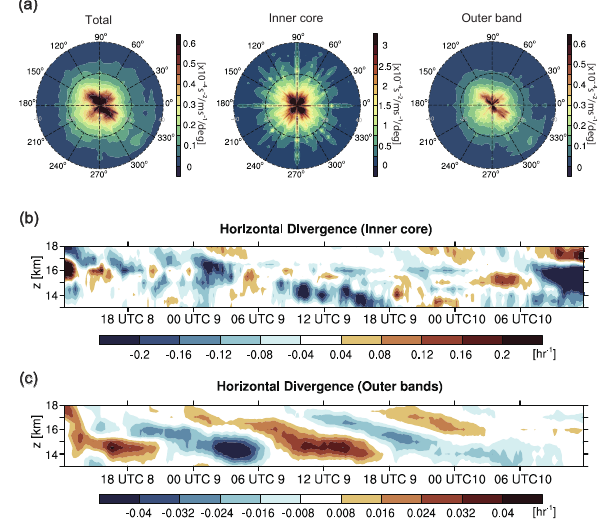
Fig. 5. (a) PSD of the HDTGW at 16kma.g.l. with respect to the horizontal phase speed (radius) and propagation direction (az- imuthal angle) in the total (left), inner core (middle), and outer rain- bands (right) regions of D3. The inner core is defined by a 150km radius from the typhoon center, and the outer rainband region is de- fined by a region subtracting the inner core region from D3. Two dashed rings in each circle in (a) represent phase speeds of 20 and 40ms − 1 , respectively. Time–height cross sections of domain- averaged HDTGW in the inner core and outer rainband regions are shown in (b) and (c) ,